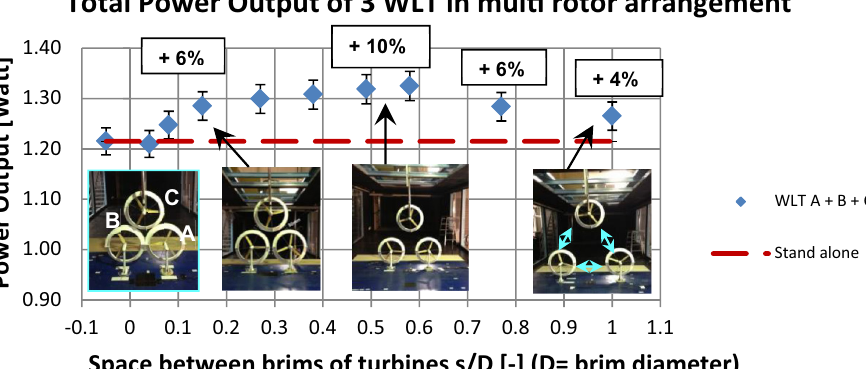
Fig. 3. Total power output of 3 Wind lens turbines in multi rotor arrangement. The red broken line indicates the sum of each power output of stand-alone turbines.